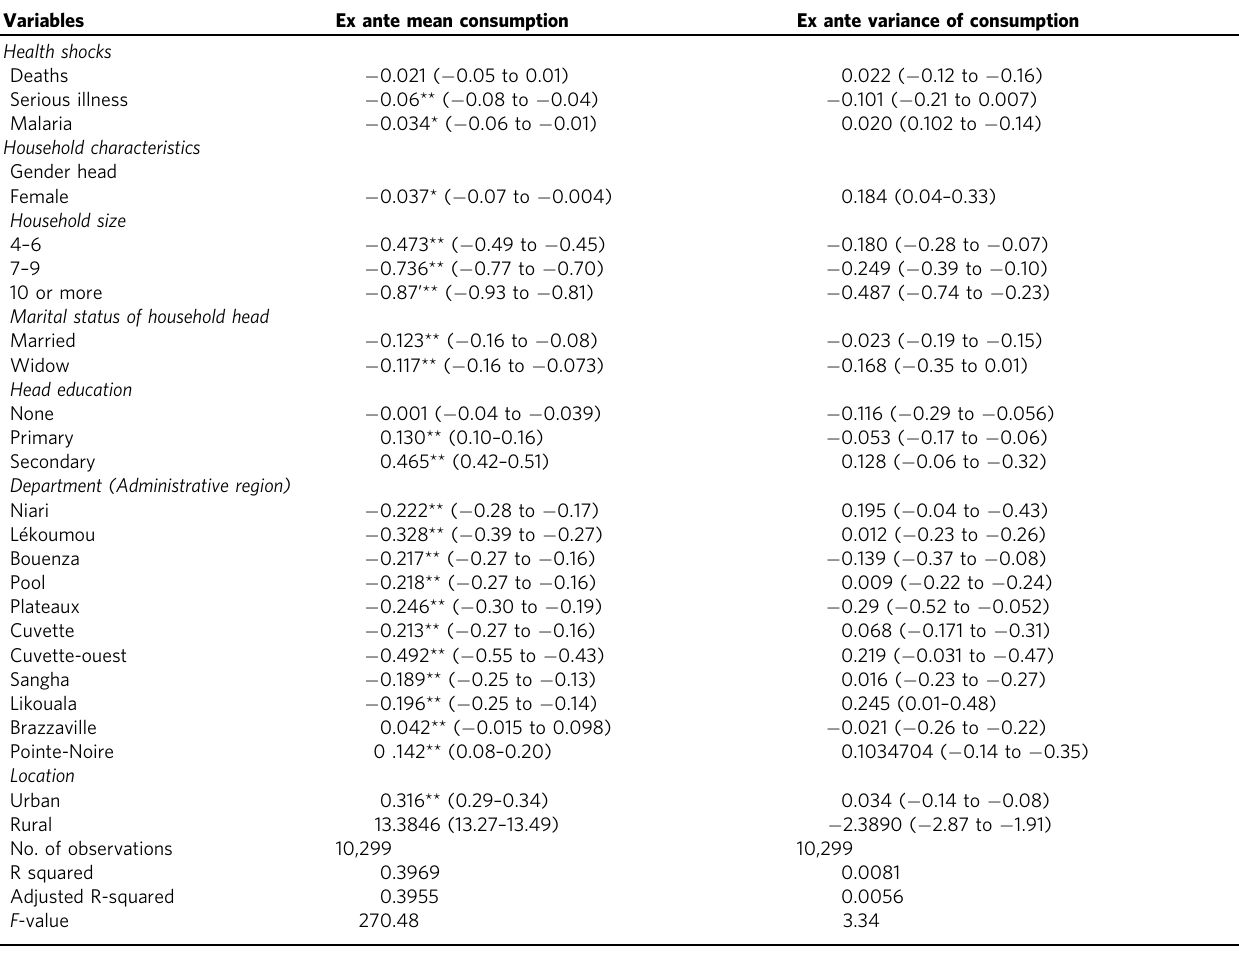
* and ** indicate signi fi cance at the 5% and 1% levels. Note : These are the results of the model estimation. 1. The dependent variable for the fi rst estimation is the ex ante mean of consumption. 2. The dependent variable for the second estimation is the ex ante variance of consumption. The categories female (gender), rural (place of residence), Kouilou (department), higher/professional (education), single (marital status) and (Novignon et al., 2012; Wagstaff, 2002; World Health Organization, 1946) (household size) were used as references.